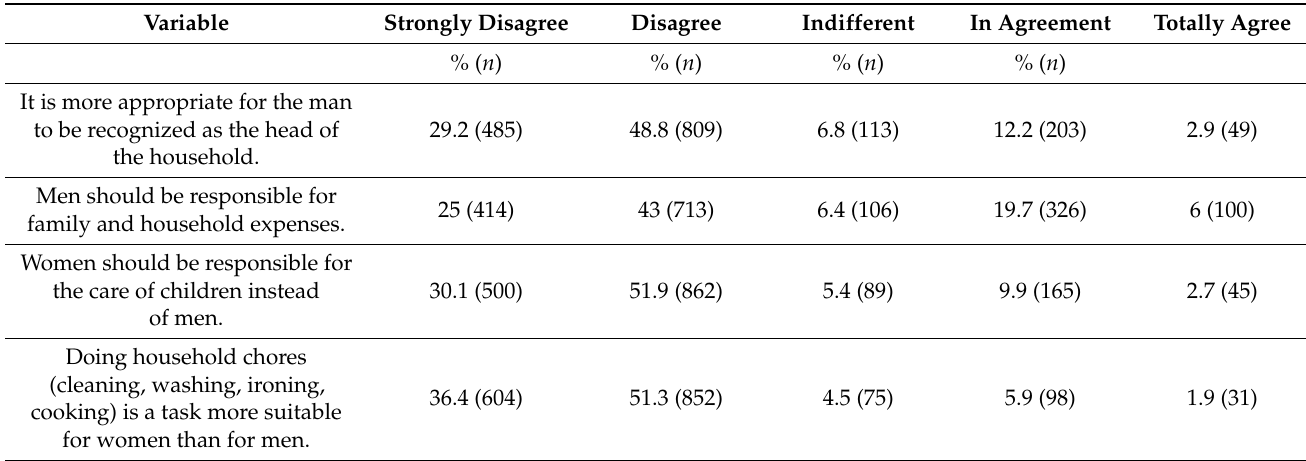
Table 3. Descriptive statistics of cognitive social